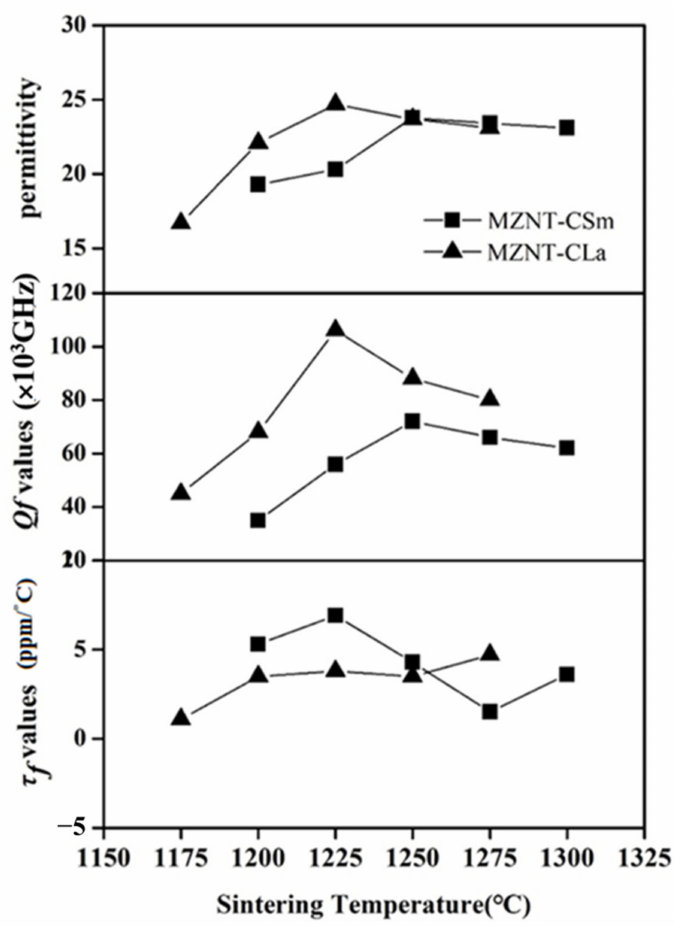
Figure 7. The dielectric properties of the 0.88(Mg 0.6 Zn 0.4 ) 0.95 Ni 0.05 TiO 3 -0.12Ca 0.6 La 0.8/3 TiO 3 / Ca 0.8 Sm 0.4/3 TiO 3 ceramics as a function of the sintering